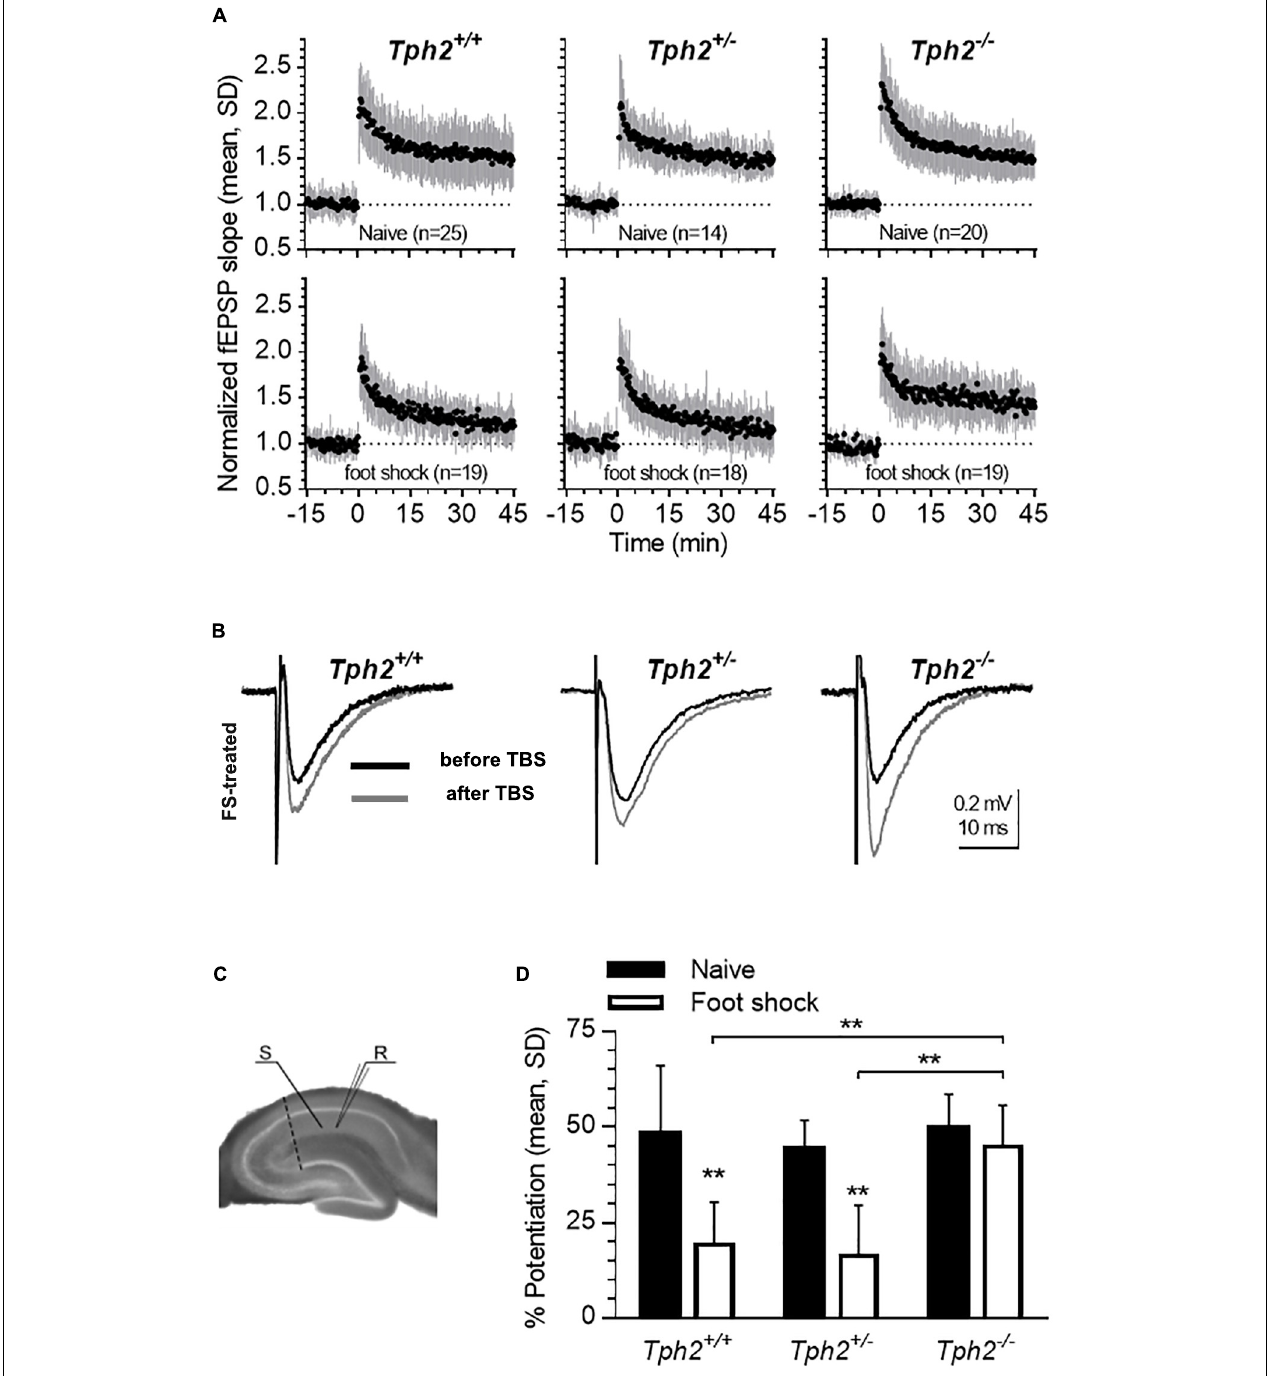
FIGURE 5 | Lack of 5-HT impedes foot shock-induced reduction in hippocampal long-term potentiation (LTP). (A) Time-course of LTP in slices obtained from naïve and foot shock-treated mice ( Tph2 + / + , Tph2 + / − , and Tph2 − / − mice; naïve: n = 8,6,5; foot shock: n = 5,6,6). Mean ± SD of fEPSP slope values normalized to the baseline mean from 5 to 0 min before theta burst stimulation (TBS). Numbers (n) in graphs indicate slices tested, including replicates per mouse. (B) Representative traces of recordings foot shock-treated Tph2 + / + , Tph2 + / − , and Tph2 − / − mice before and after TBS. (C) Positioning of stimulation electrode (S) on Schaffer collaterals and recording electrode (R) in CA1. The dashed line indicates a cut made between cornu ammonis area 1 (CA1) and cornu ammonis area 3 (CA3) to prevent recurrent propagation of action potentials. (D) LTP is expressed as the percent change measured 40–45 min after TBS in respect to baseline between naïve and foot shock-treated Tph2 + / + , Tph2 + / − , and Tph2 − / − mice. ∗∗ p < 0.01. Two-way ANOVA, followed by Sidak’s post hoc test.